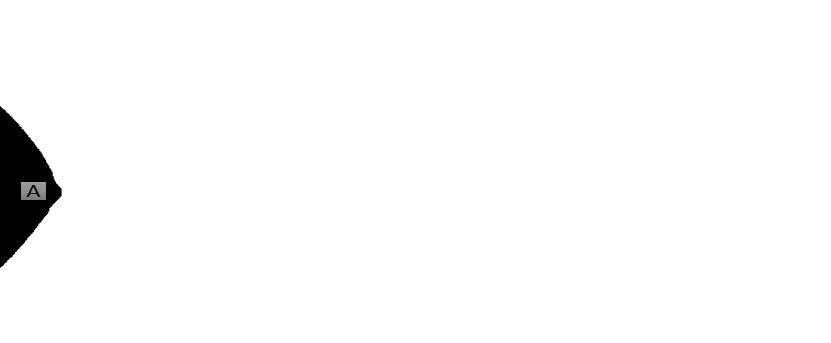
Figure 2. Different locations ( A – E ) where features were extracted for ROI